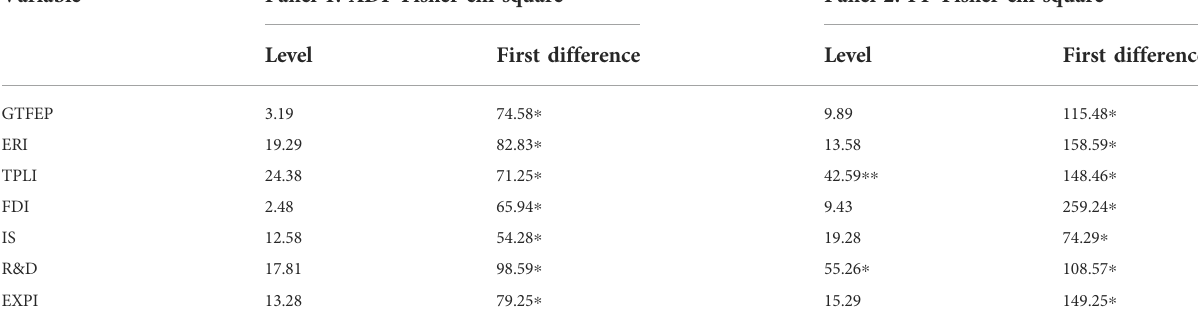
TABLE 4 Fisher chi-squared panel unit root test. Variable Panel 1: ADF-Fisher